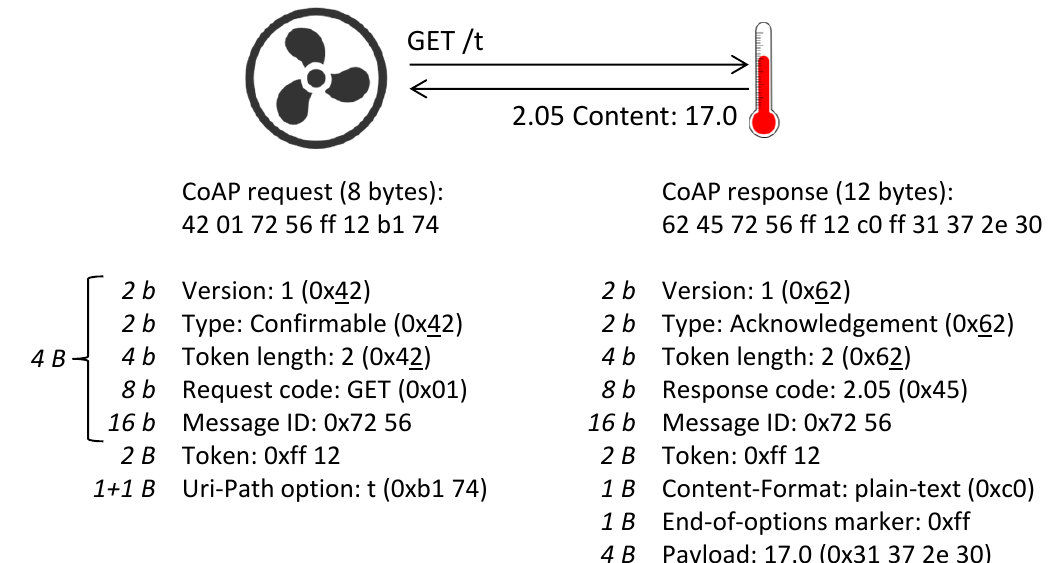
Figure 1. Anatomy of a typical CoAP request and